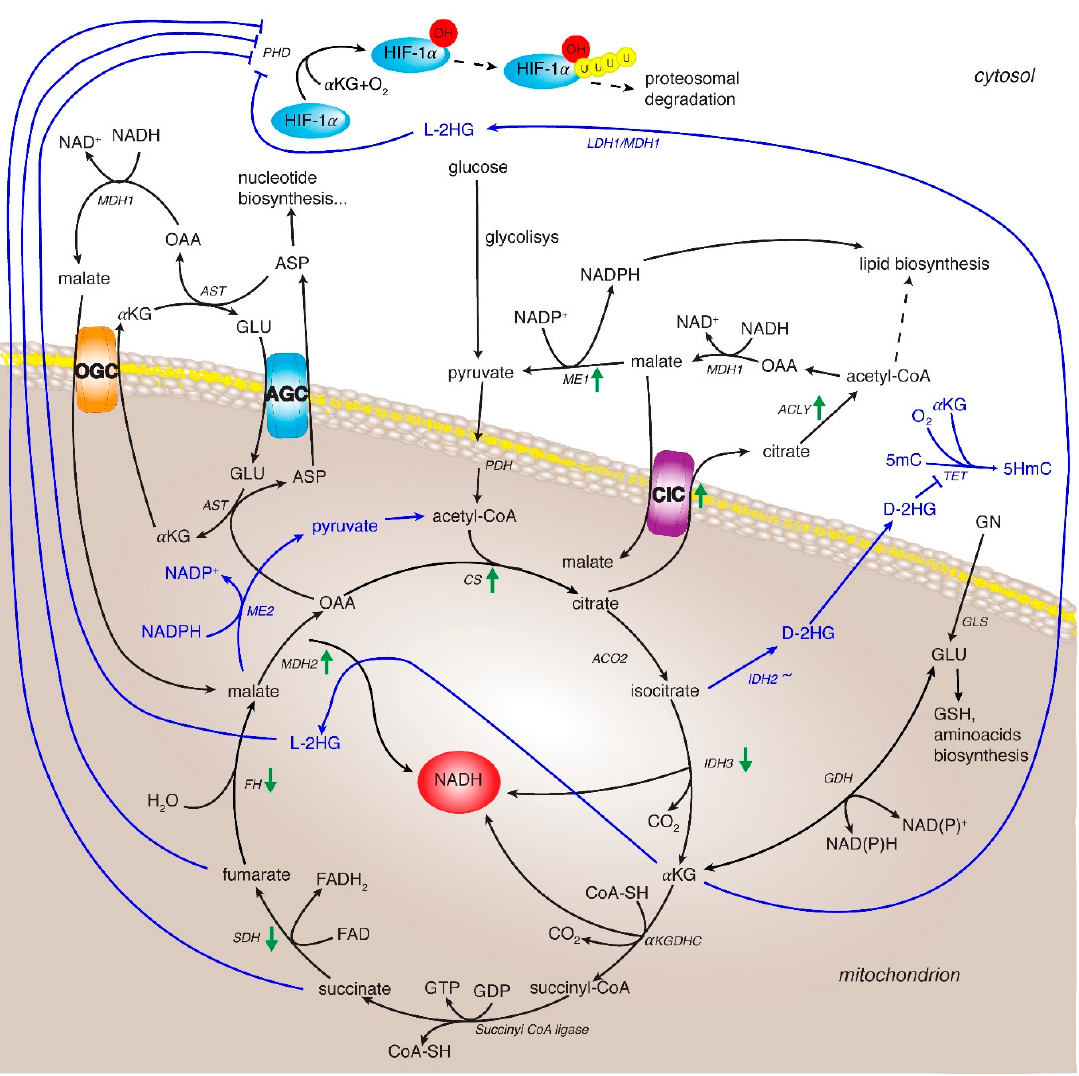
Figure 2. TCA cycle rewiring and mitochondrial signaling in cancer and HCC. The TCA cycle metabolic flux is represented by black arrows and specific enzymes. Three of them catalyze irreversible reactions: the citrate synthase, the isocitrate dehydrogenase 3 and the α -ketoglutarate dehydrogenase complex. Blue lines indicate the reprogramming of metabolic reactions in cancer. Green arrows indicate up- and down-regulation of expression and / or activity of TCA cycle and related enzymes in HCC.